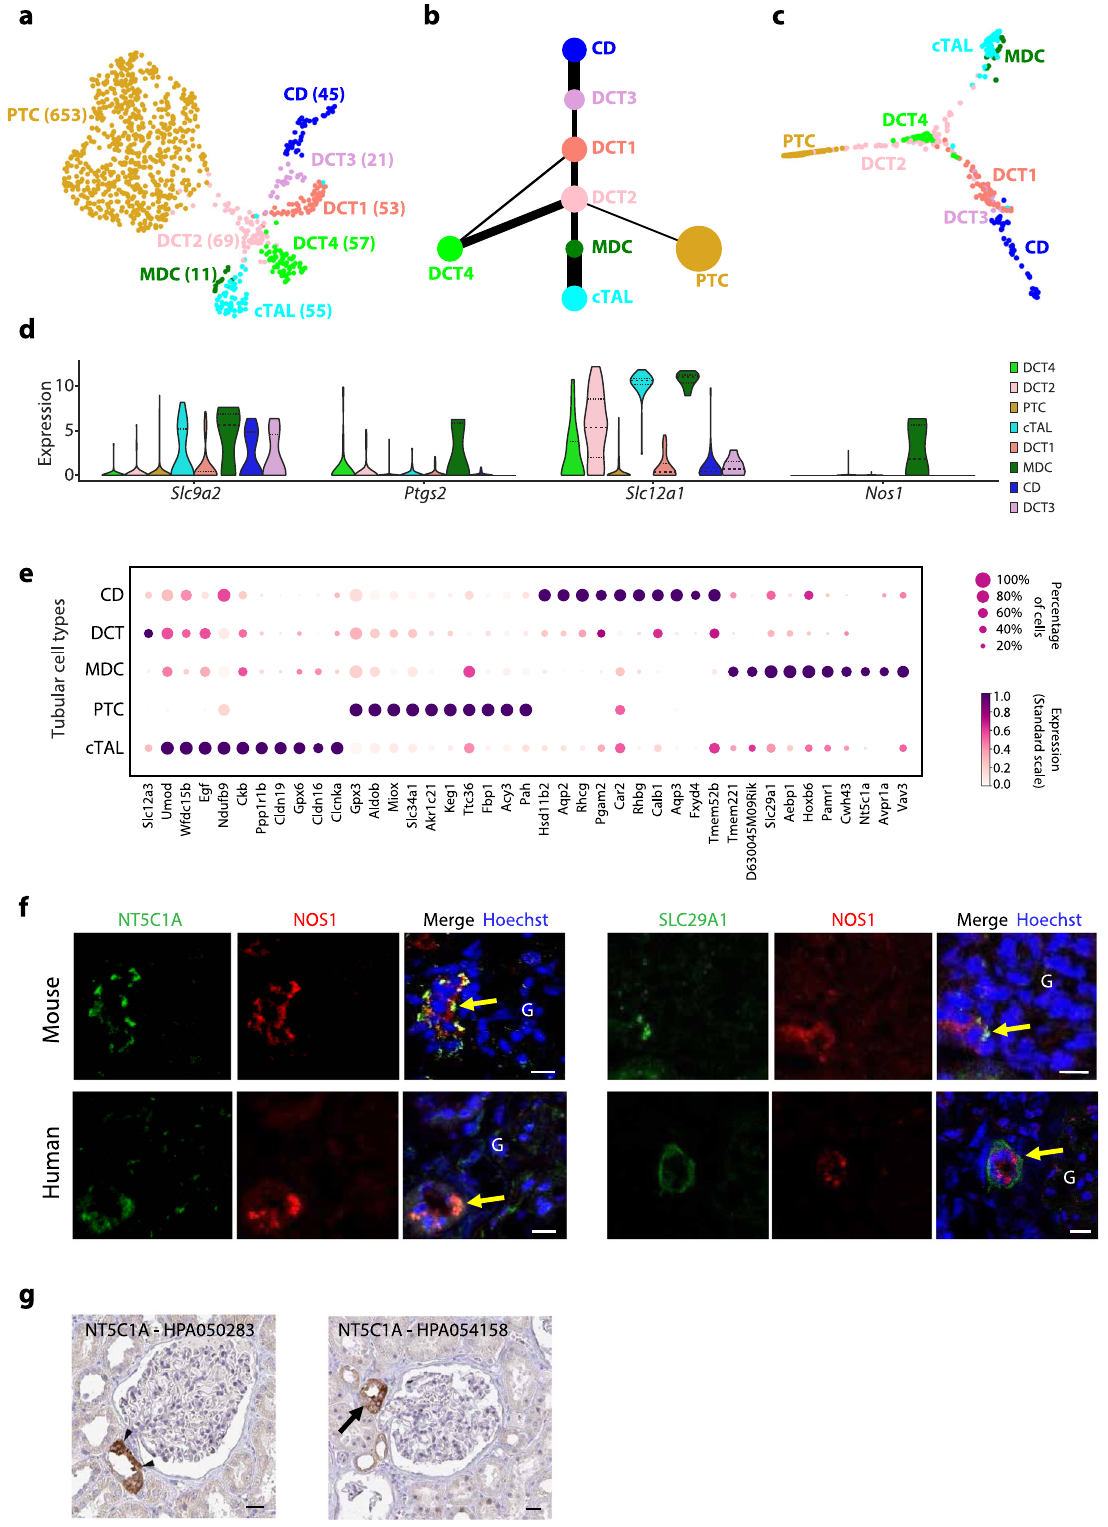
thickness. After deparaf fi nisation, antigen retrieval was done by heating at 98 °C for 20 min. The primary antibody was incubated at 4°C overnight. Then we used a Vectastain Elite ABC HRP kit (PK-7200 Vector Labs) for the subsequent staining procedure and followed the manufacture ’ s protocol. Nuclear staining was per- formed using hematoxylin. The confocal microscope Leica TCS SP8 or Zeiss SLM 710 was used for fl uorescence imaging. We also used immunohistochemistry images of Human Protein Atlas (www.proteinatlas.org,